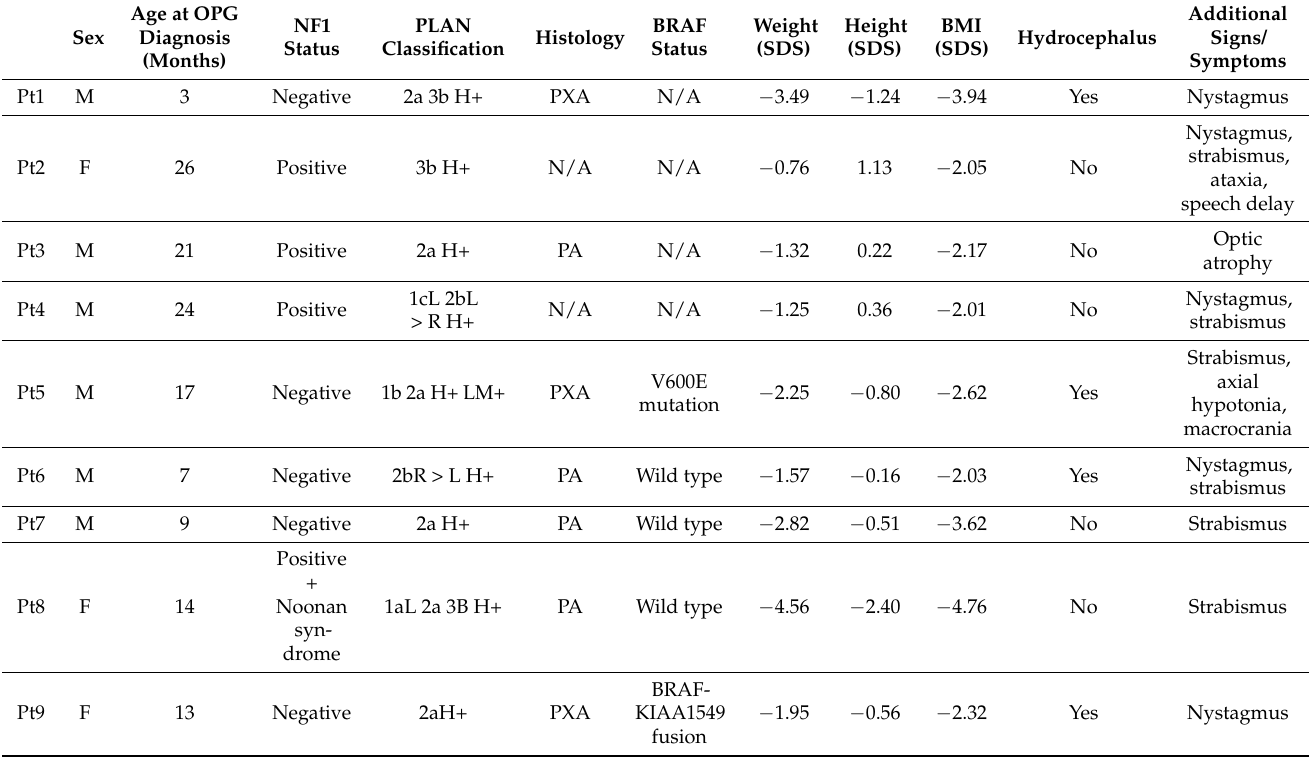
Table 1. Clinical, pathological and biological data for nine cases of diencephalic syndrome related to optic pathway